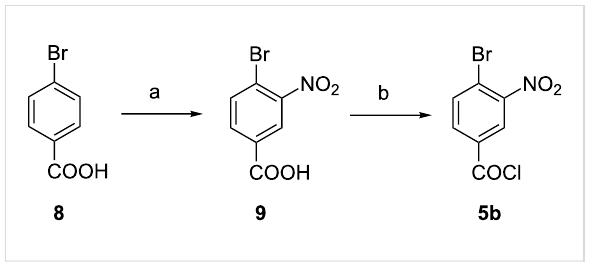
Figure 5: Synthesis of 4-bromo-3-nitrobenzoyl chloride ( 5b ). Condi- tions: a) HNO 3 /H 2 SO 4 , 3 h 0 °C, 2 h, room temperature, 98%, b) SOCl 2 , 2 h reflux, not isolated.